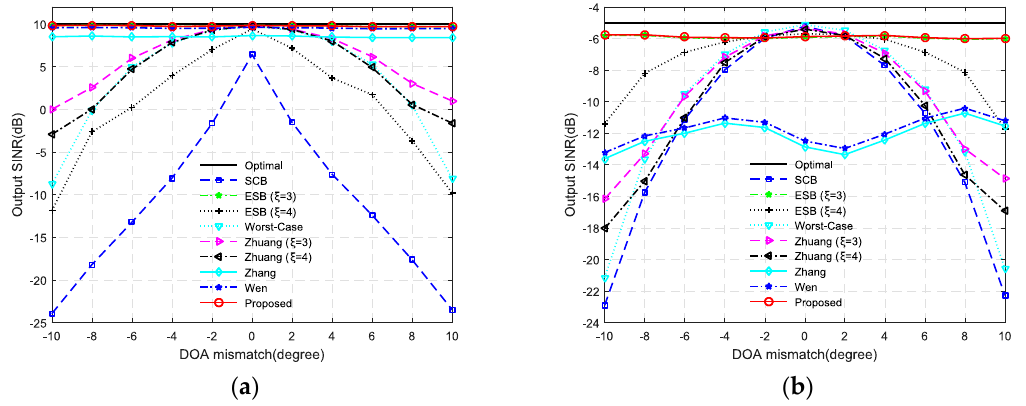
Figure 7. Output SINR versus DOA mismatch: ( a ) SNR = 0 dB; and ( b ) SNR = − 15 dB.